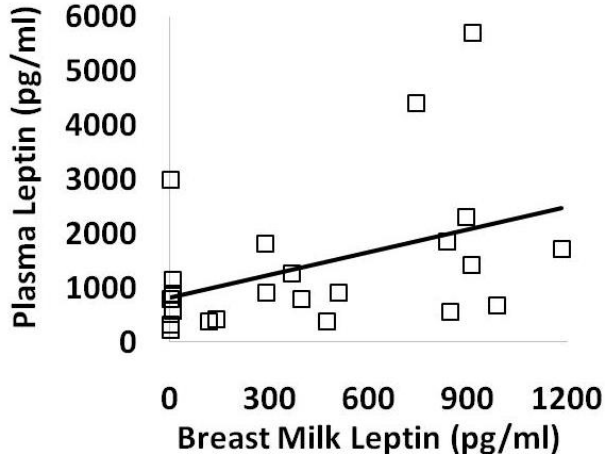
Figure 4. Plasma leptin levels were directly associated with breast milk leptin levels across the 3 weeks of the study protocol by simple linear regression (N = 24, R = 0.42, p <